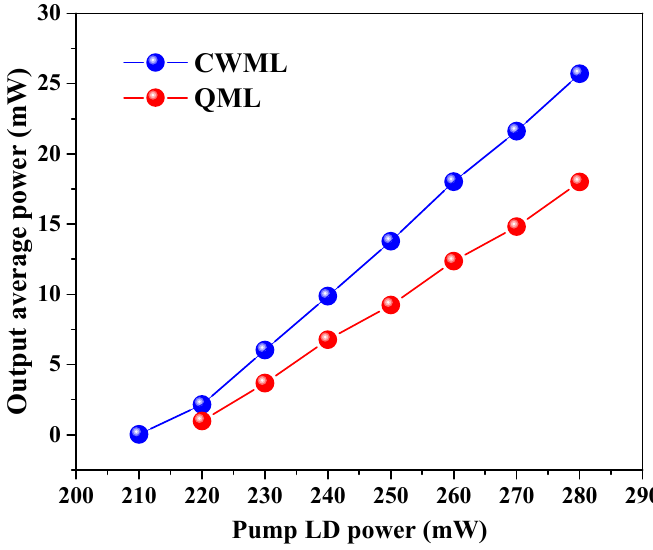
Figure 8. Output average power versus the pump at CWML and QML operation